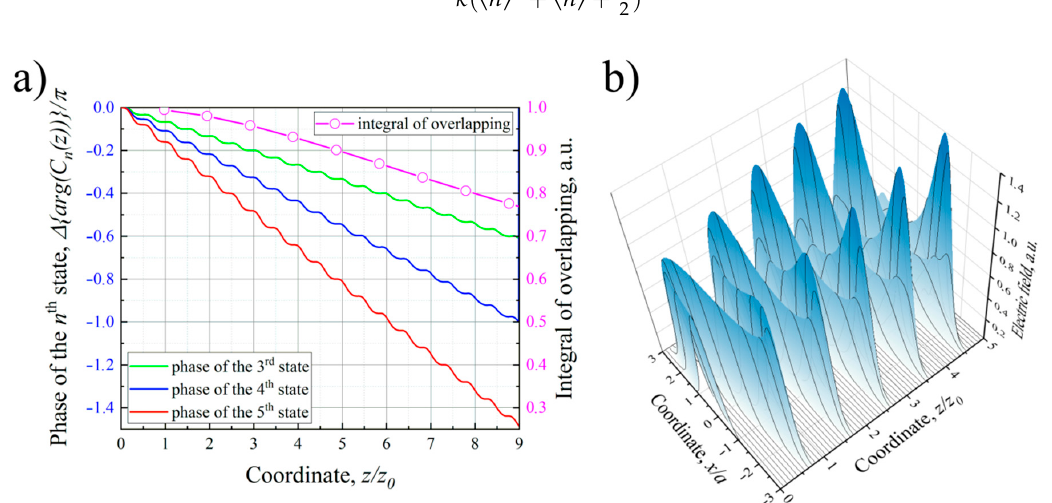
Figure 6. ( a )Phase shifts 𝛥𝜙(𝑧) for different transverse states of the beam prepared initially in the coherent state in the non-ideal waveguide. The average number of quanta ⟨𝑛⟩ = 5 , parameter 𝜅 = 0.01 . Dotted curve represents the data on 𝑧 -dependence of integral of overlapping (see the text). ( b ) Evolution of the transverse spatial structure of the beam along the propagation in the non-ideal waveguide.